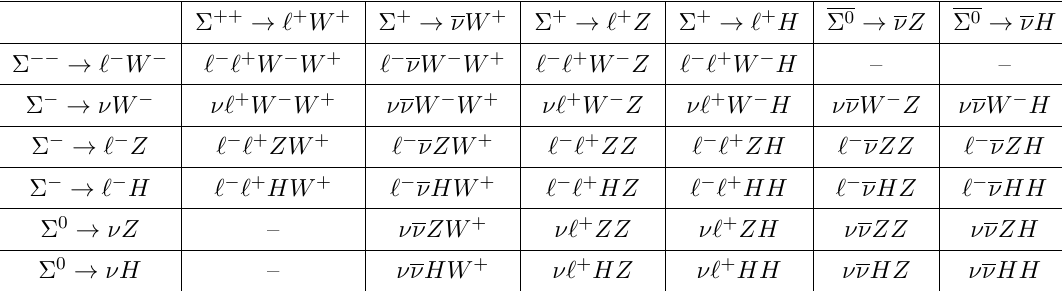
Table 5 . Exotic lepton decay channels to SM particles along with the (cid:12)nal state signatures of pair/associated